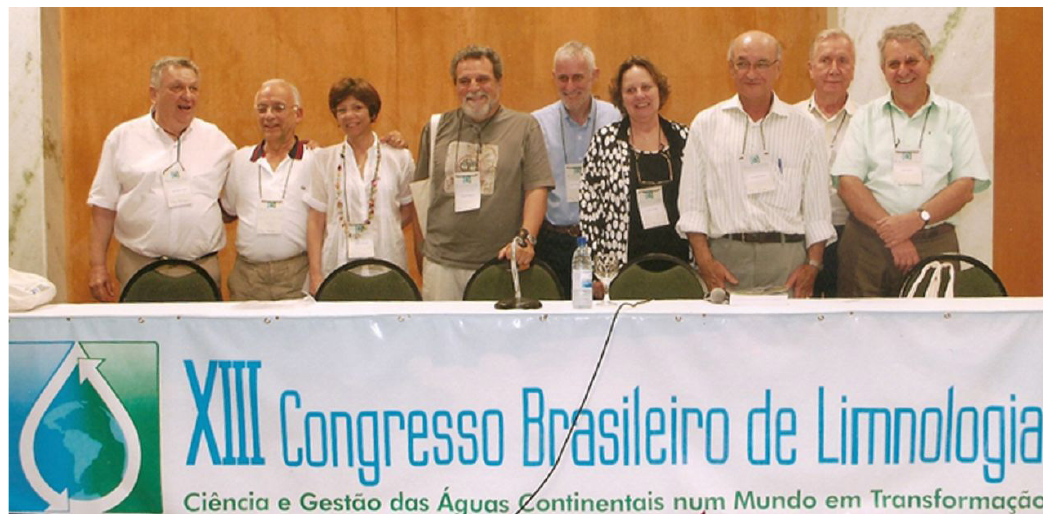
Figure 2. Albano (second from right) with colleagues at the XIII Brazilian Limnology Congress in Natal 2011: José Galizia Tundisi, Carlos Eduardo de Mattos Bicudo, Denise de Campos Bicudo, Francisco Antônio Rodrigues Barbosa, Irineu Bianchini Júnior, Lezilda Carvalho Torgan, Francisco de Assis Esteves, Albano Schwarzbold and Raoul